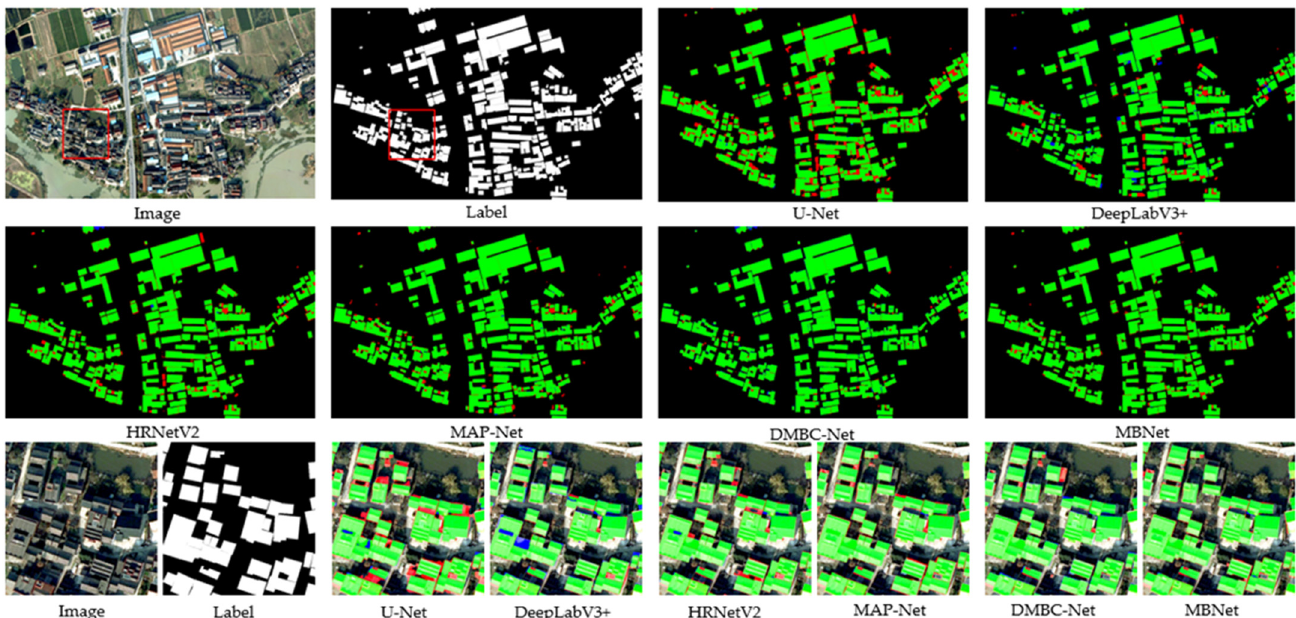
dataset. The bottom row is a close-up view of the red box.